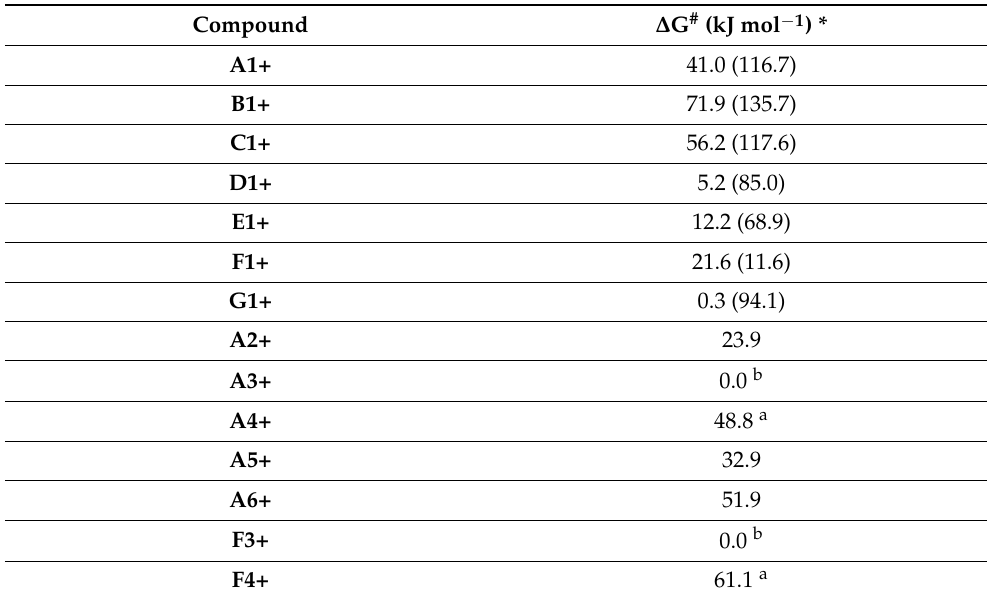
Table 2. Gibbs free energies of activation for the reaction of non-methylated and methylated hetero- cycles with methyl-thiolate or cysteamine a